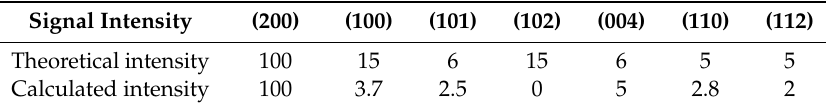
Figure 13. XRD patterns recorded on commercial h-BN ( black ) and on LiBN05 ( red ). Table 4. Main XRD parameters of commercial h-BN and LiBN05.